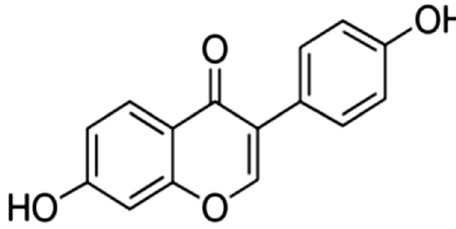
Fig. 11 Structure of caffeic acid (3,4-dihydroxycinnamicacid) Fig. 12 Structure of daidzein (4 ′